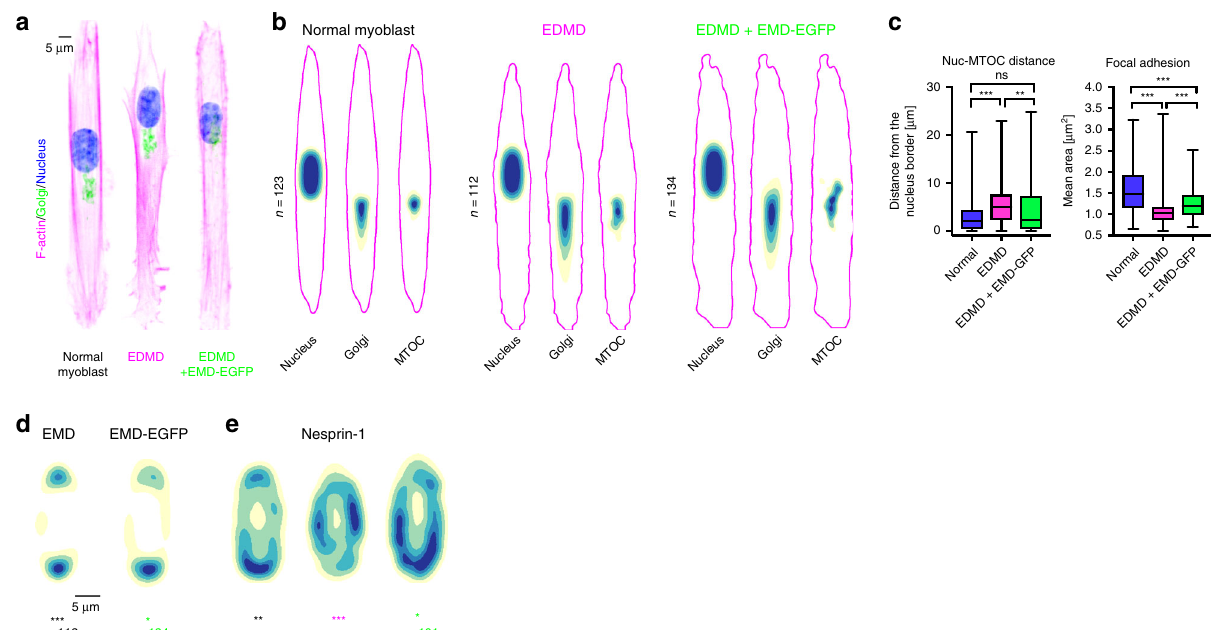
Fig. 5 Nuclear front-rear polarity rescue in primary myoblasts. a Single primary normal (left), EDMD (middle) and EMD-EGFP-rescue (right) myoblasts on 10 μ m micro-patterned lines. b Distribution maps of the nucleus, Golgi, and MTOC in normal (left panel), EDMD (middle panel) and EMD-EGFP-rescue cells (right panel). The outline represents the F-actin border of the averaged cells. c Measurement of nucleus-MTOC distance (n Normal = 123, n EDMD = 110, n EDMD + EMD-EGFP = 189 cells from three independent experiments) P normal vs. EDMD = 1.3 × 10 − 5 , P EDMD vs. EDMD + EGFP = 0.0013. Measurement of size